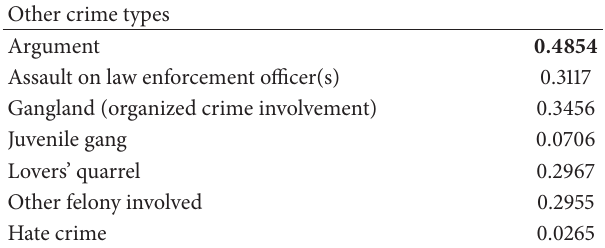
Table 7: Drug dealing correlation with other crime types.